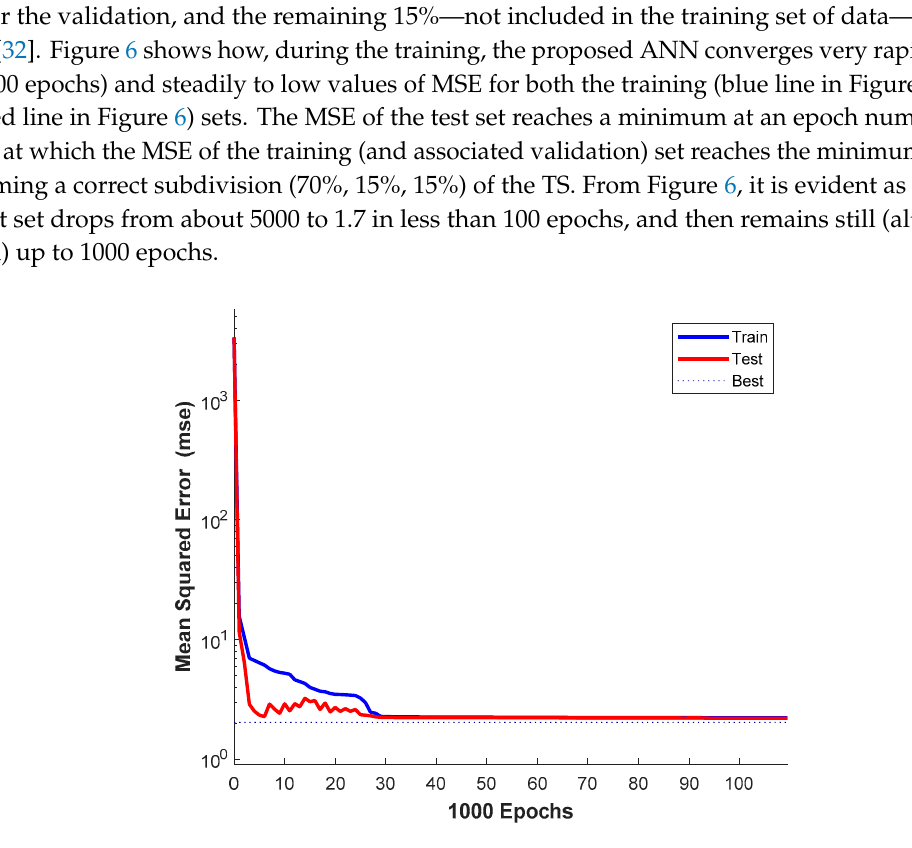
Figure 6. Training performance of the ANN.